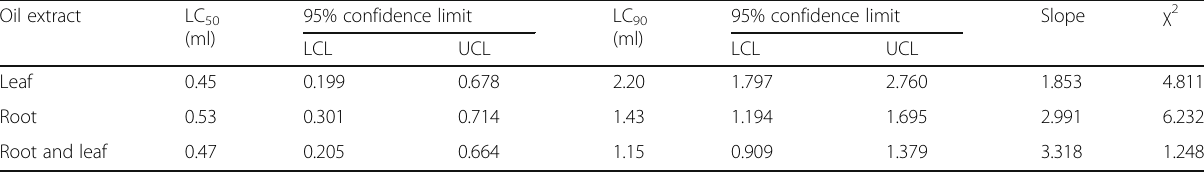
Table 4 Lethal concentration effect of Petiveria alliacea oil extract after 120 min post-treatment period Oil extract